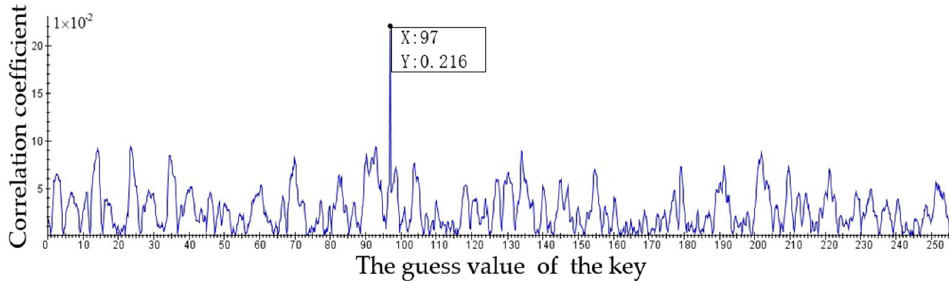
Figure 7. The fourth byte of 1 V CPA attack result.